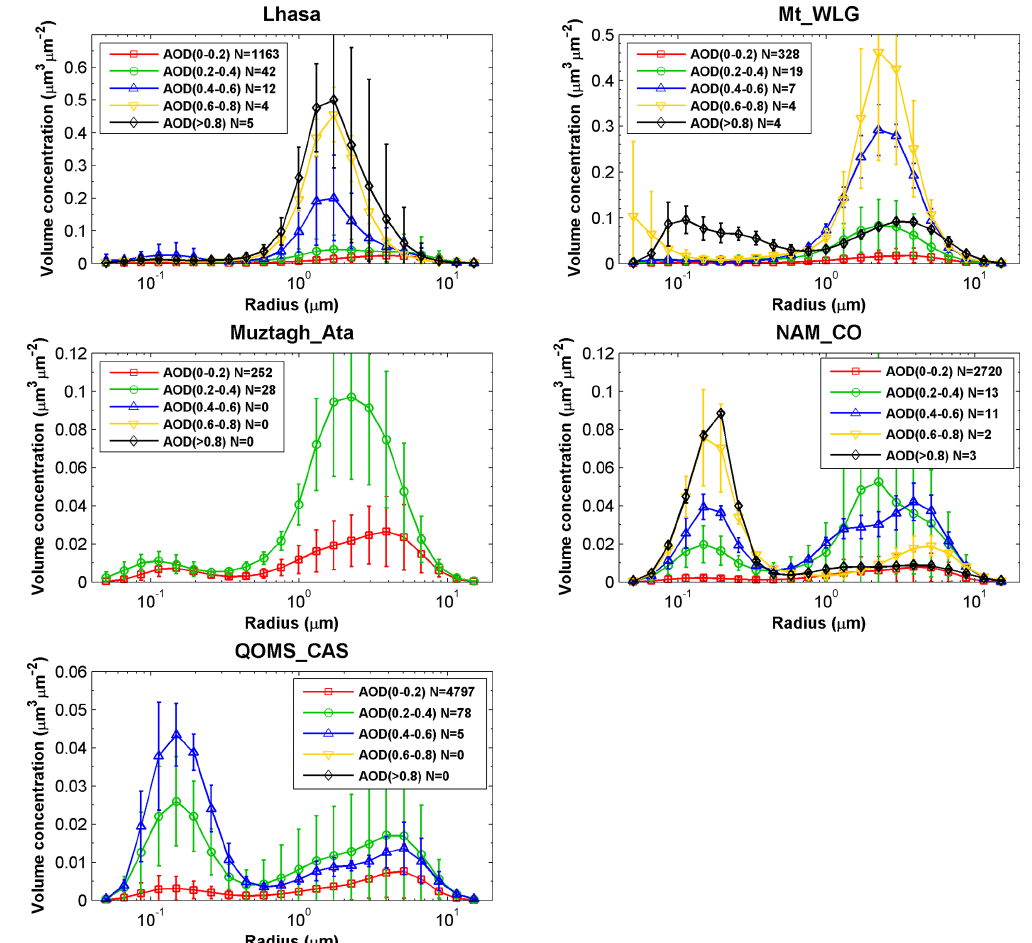
Figure 11. Aerosol size distribution binned by CE318_AOD at the five sites on the Tibetan